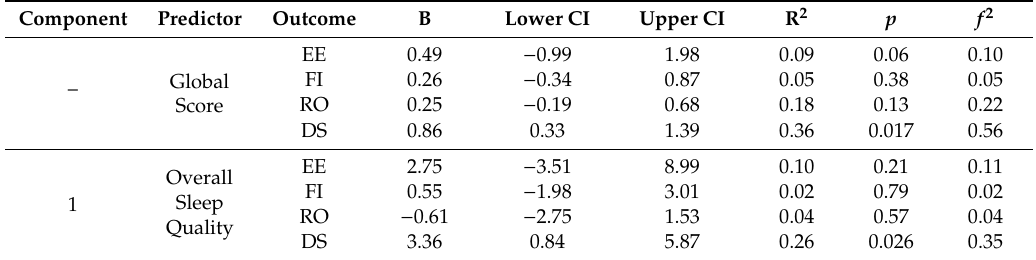
Table 1. Regression analyses assessing the link between sleep quality (Pittsburgh Sleep Quality Index (PSQI) scores) and occupational outcomes. EE = emotional exhaustion; FI = functional impairment, RO = role overload, DS = daytime sleepiness. CI = confidence interval. Bold indicates a statistically significant relationship between the two listed factors ( p < 0.05). Cohen’s f 2 of 0.10 = a small e ff